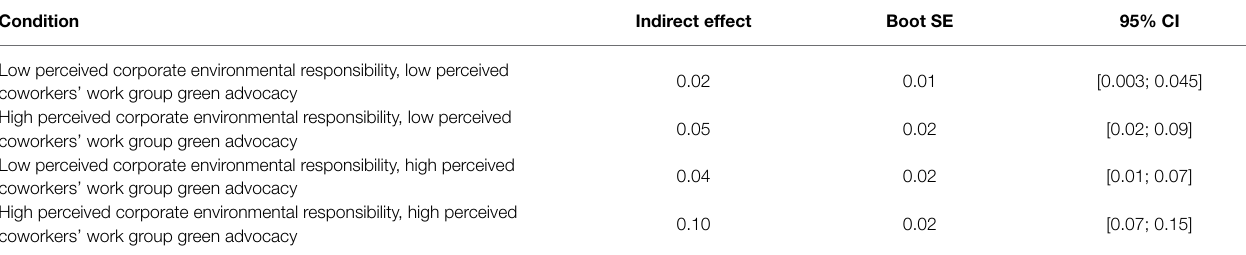
TABLE 6 | Bootstrap results for the conditional indirect effects. Condition